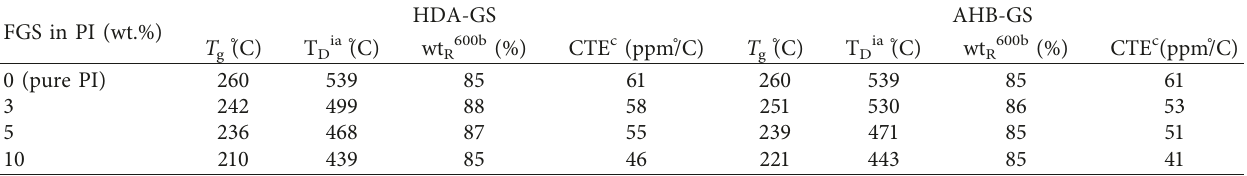
Table 5: Thermal properties of PI hybrid films (adapted from reference [113]). FGS in PI